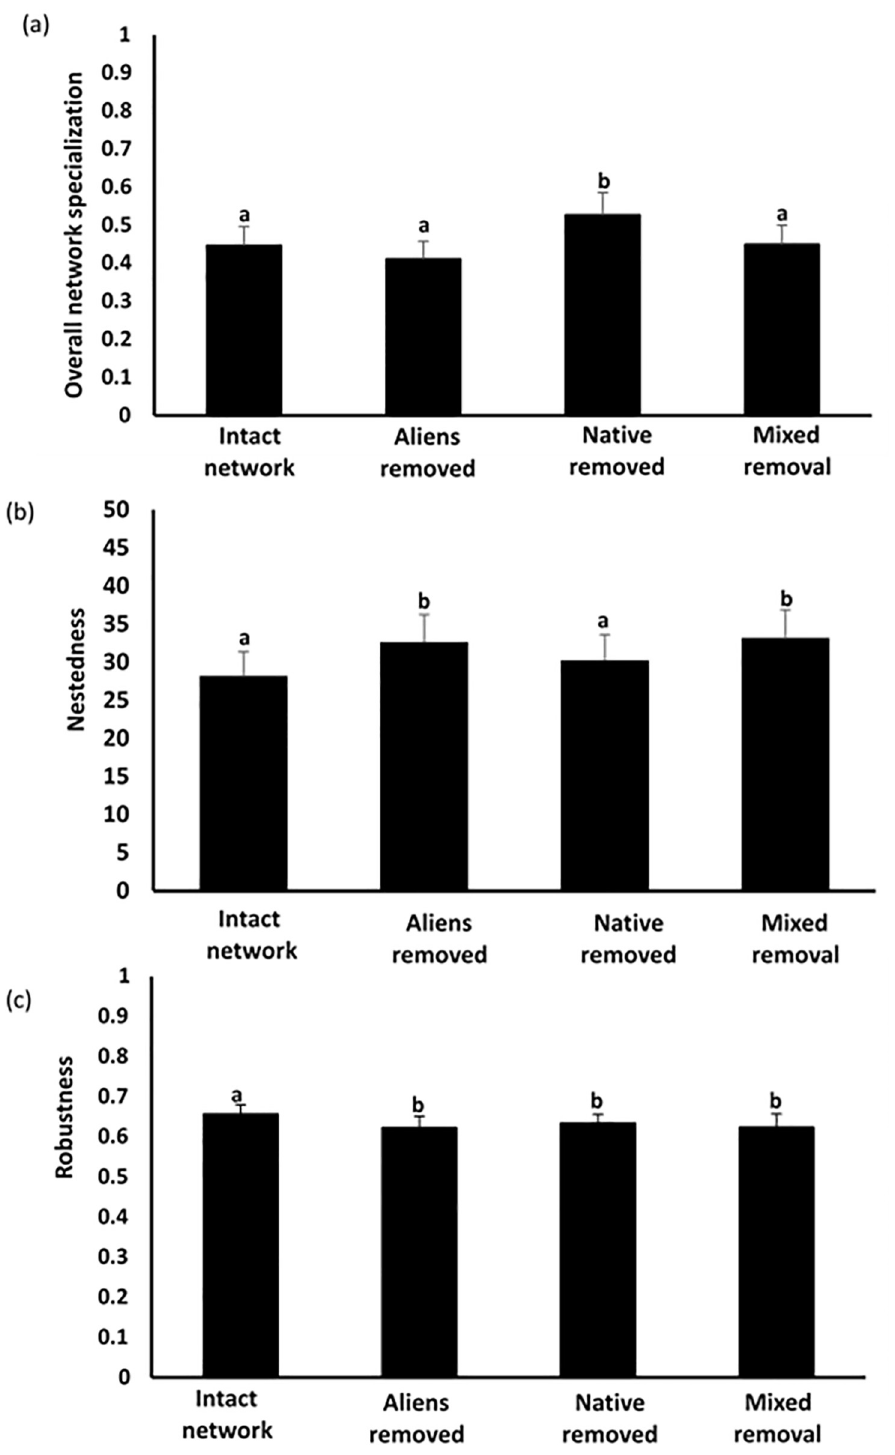
Fig 4. Structural plant-floral visitor network parameters. (a) Overall network specialization (H2), (b) nestedness and (c) robustness for the observed plant-floral visitor network (i.e. intact network) and the three extinction scenarios: “aliens removed”, “natives removed” and “random removal” (randomly exclusion of alien and natives). Different letters indicate statistical differences (p < 0.05) between simulated extinction scenarios.